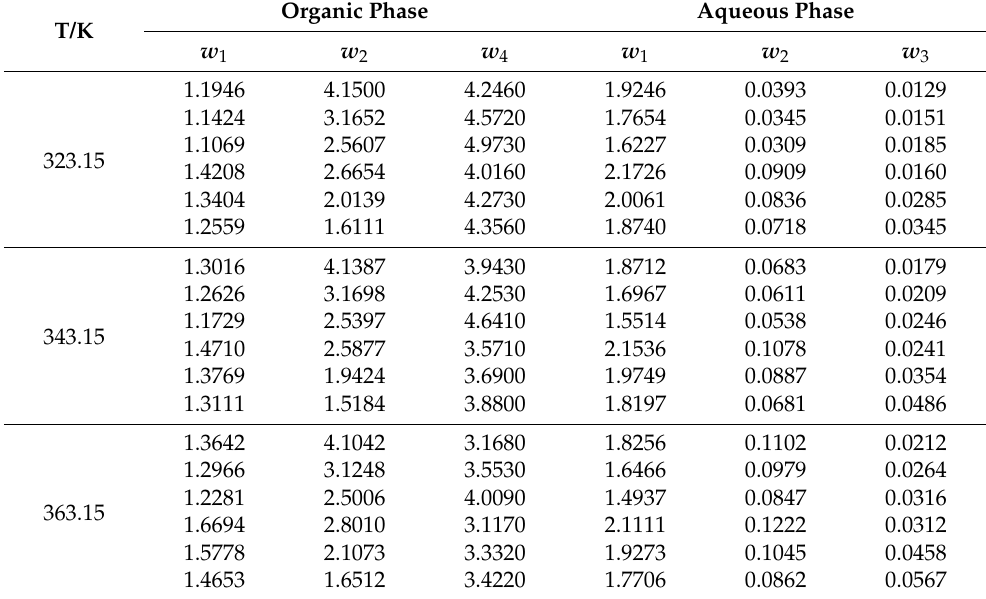
Table 3. Experimental LLE data for quaternary system LA (1) + OL (2) + OC (3) + water